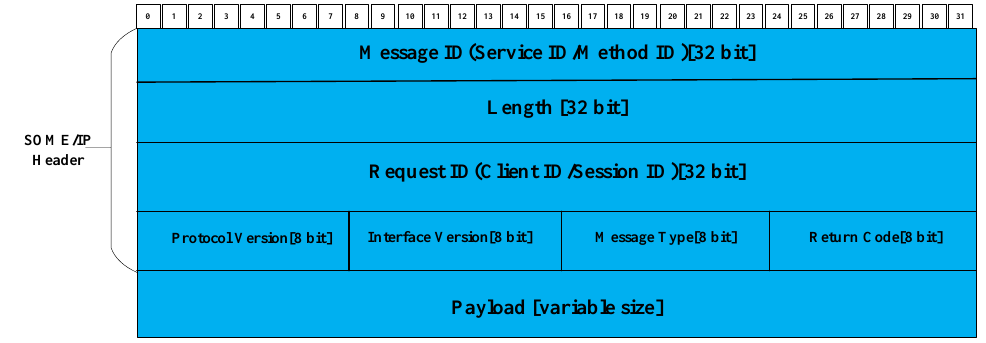
Figure 1. SOME/IP protocol data frame structure.